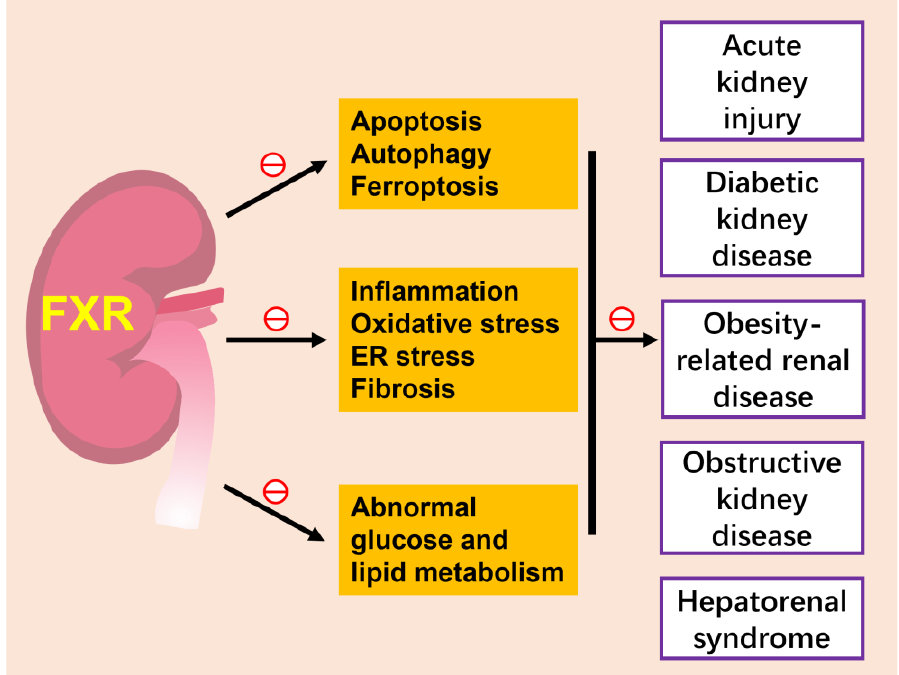
Figure 3. FXR and kidney diseases. The activation of FXR attenuates various kidney diseases, such as acute kidney injury, diabetic kidney disease, obesity-related kidney disease and hepatorenal syn- drome, by inhibiting several cell death modes of renal tubular epithelium, including apoptotic, au- tophagy and ferroptosis, ameliorating inflammation, oxidative stress and fibrosis and improving abnormal glucose and lipid metabolism. The role of FXR in renal neoplasia is slightly unclear and is not included in this figure. ㊀ indicates inhibition.